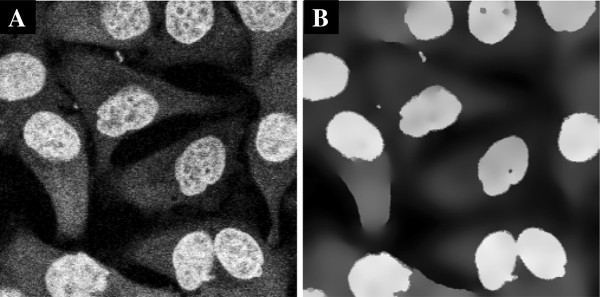
Smoothing of stained nuclei of Hela-Kyoto cells in 2D by Example 4. A) Raw nuclei stain, B) smoothing of A by edge enhancing diffusion (method = ’eed’). After edge enhancing diffusion the image becomes more piecewise constant and better suited for segmentation.